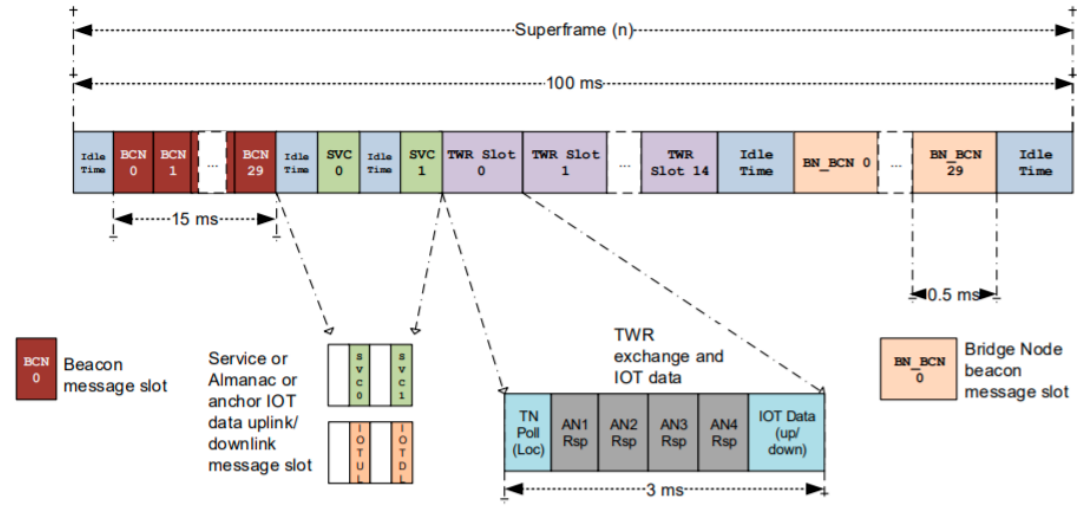
Figure 4. Decawave RTLS—Superframe Structure [36].